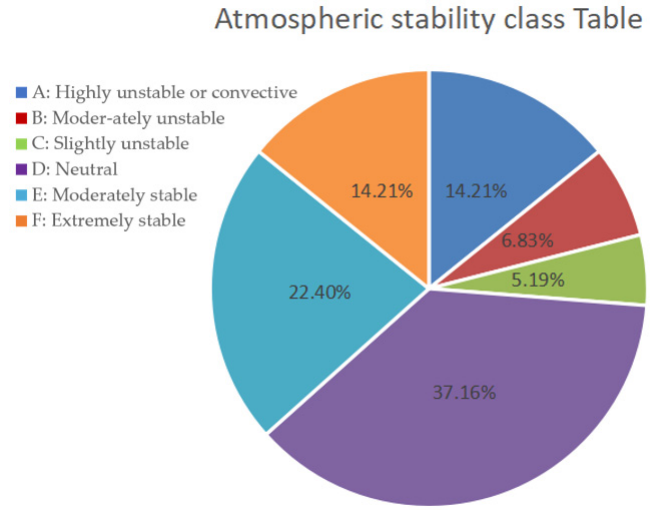
Figure 3. Xutuozi Wind Farm’s atmospheric stability classification.